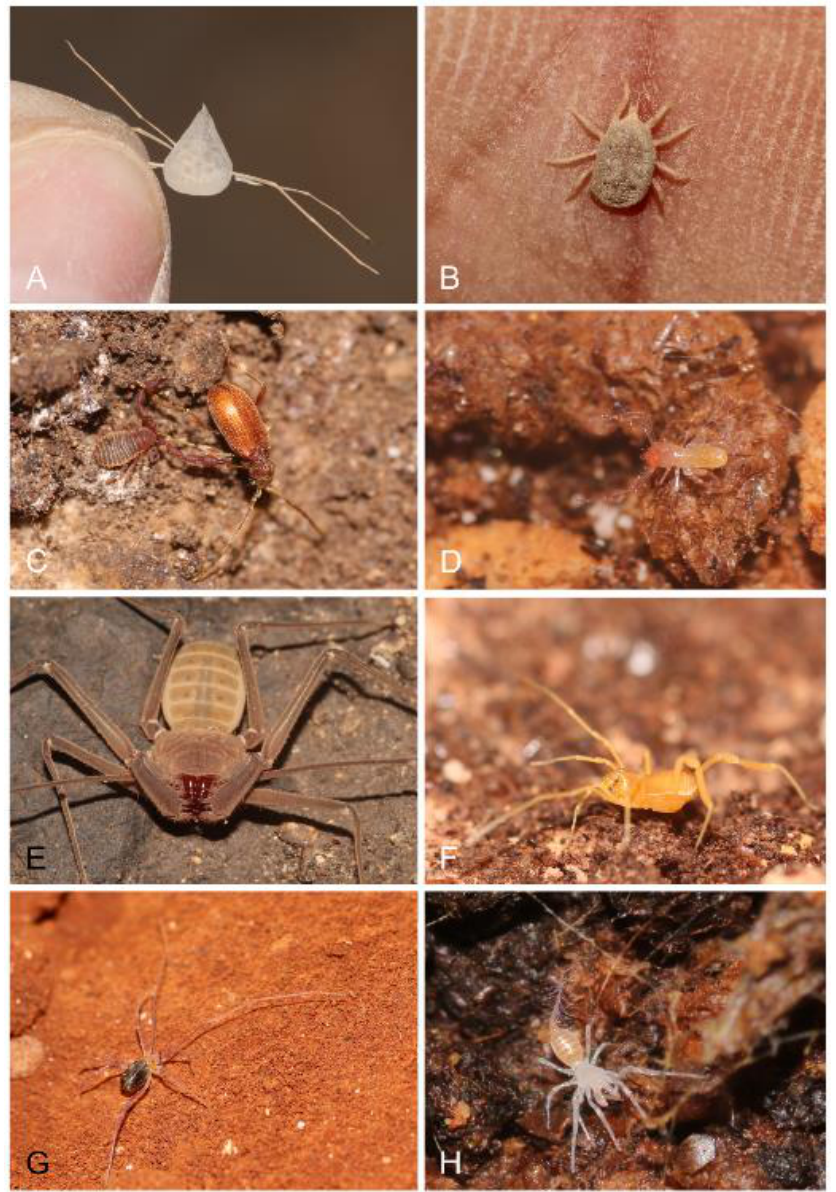
Figure 3. Arachnids found during cave surveys. ( A ): Argas vespertilionis (Latreille, 1796), (Acari, Argasidae); ( B ): Ornithodoros tholozani Laboulbène and Mégnin, 1882, (Acari, Argasidae); ( C , D ): Pseudoscorpiones; ( E ): Charinus israelensis Miranda, Aharon, Gavish-Regev, Giupponi, and Wizen, 2016, (Amblypygi, Charinidae); ( F ): Haasus naasane Aharon et al., 2019 (Opiliones, Pyramidopidae); ( G ): Opilioacaridae (Acari); ( H ): Eukoenenia Borner, 1901 (Palpigradi, Eukoeneniidae). Pictures: Shlomi Aharon.